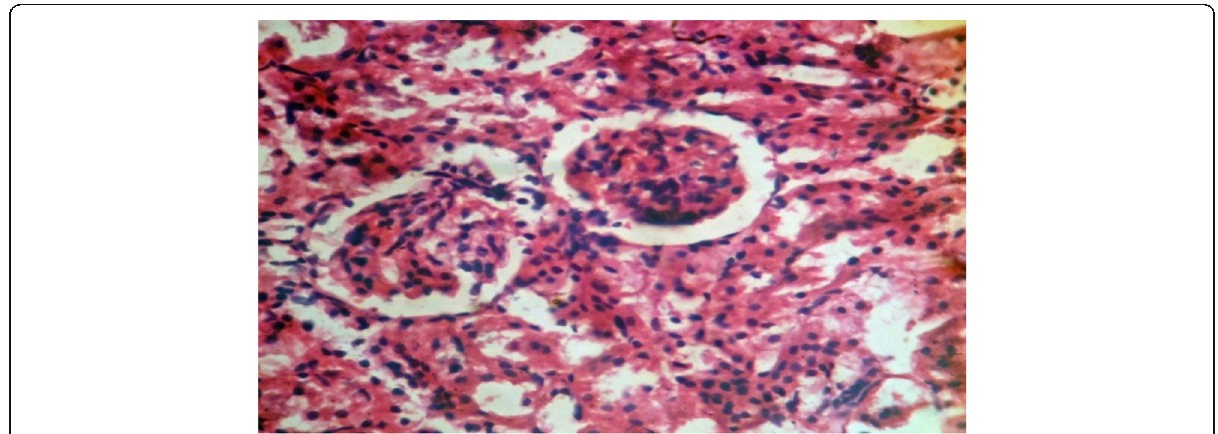
Fig. 1 (Group I) — control group of rats showing normal architecturewith well-defined Bowman ’ s capsule (BW) with glomerulus(G), proximal convoluted tubules (PCT), distal convoluted tubules (DCT), urinary space (US), and vascular pole (VP) (40X, hematoxylin-eosin